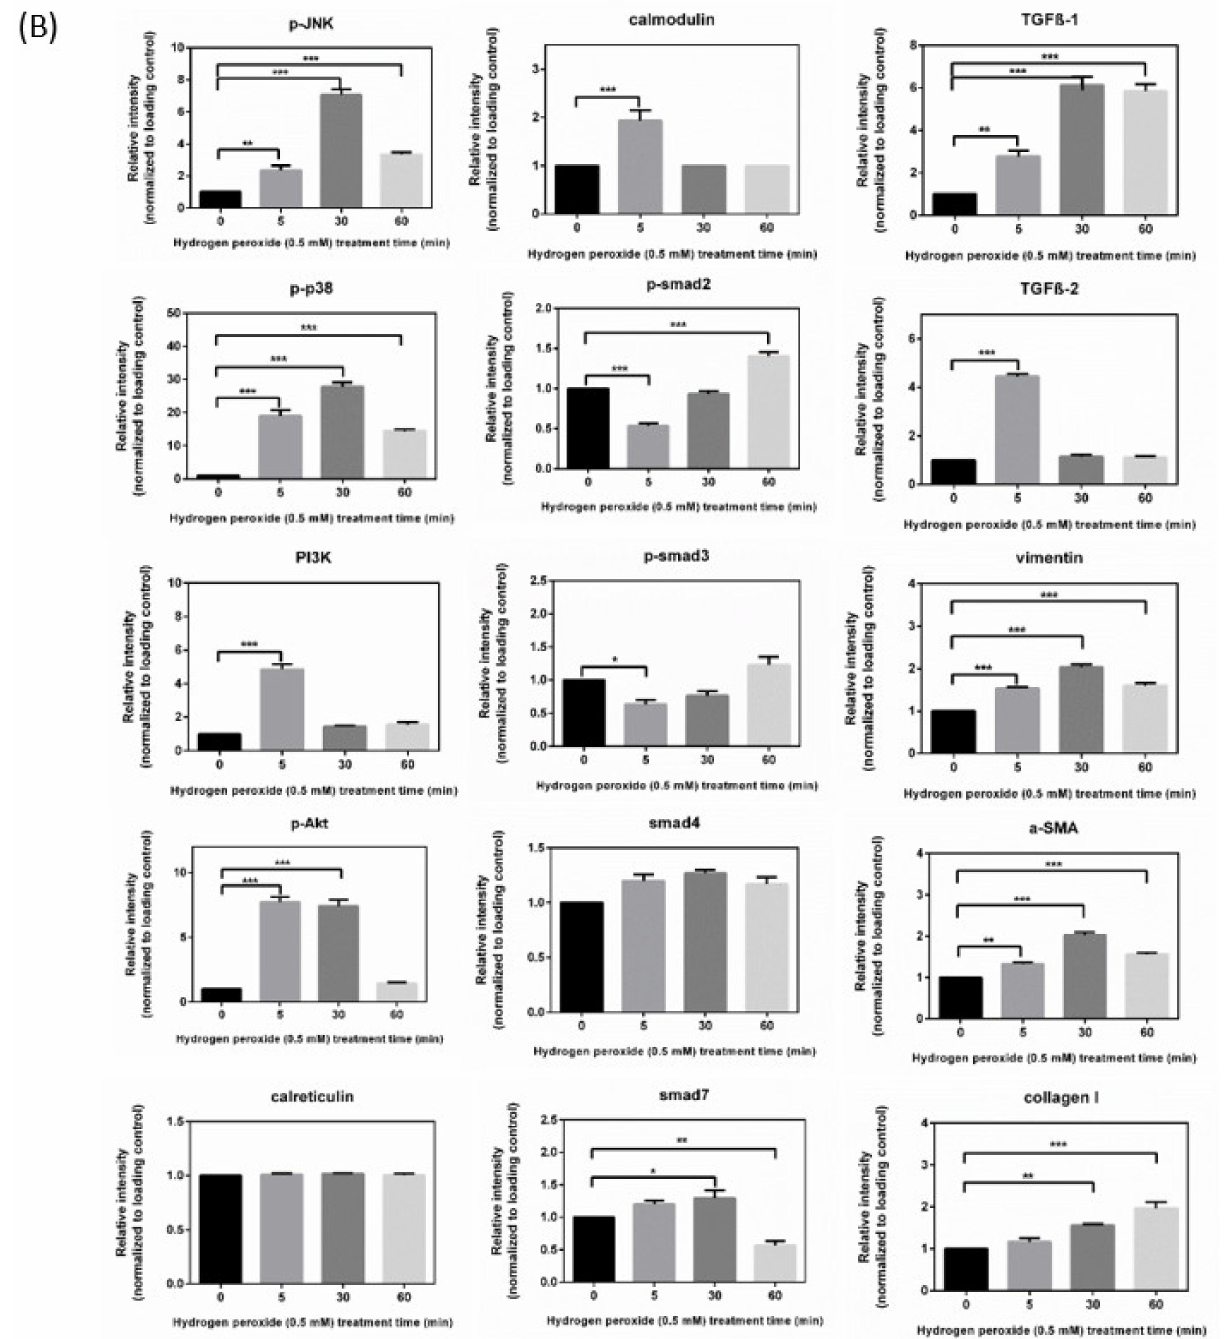
Figure 2. Immunoblot analysis and identification of H 2 O 2 -induced oxidative stress response signaling pathways. ( A ) Cells were collected after treatment with specific H 2 O 2 concentration (0.5 mM) for 5, 30, and 60 min, and cellular extracts were immunoblotted with p-JNK, JNK, p-p38, p38, PI3K, p-AKT, AKT, calreticulin, calmodulin, p-SMAD2, p-SMAD3, SMAD2/3, SMAD4, SMAD7, transforming growth factor (TGF) β -1, TGF β -2, vimentin, α -SMA, and collagen I, as shown with protein bands. Oxidative stress-dependent increases in ECM proteins, stress response, and TGF- β family members were observed over time. Numbers under each protein band reflect the densitometry value. ( B ) The protein expression intensities were quantified in relation to the loading control. Statistic chart were represented as means ± SEM. *, p < 0.05; **, p < 0.01; ***, p < 0.001 ( n =